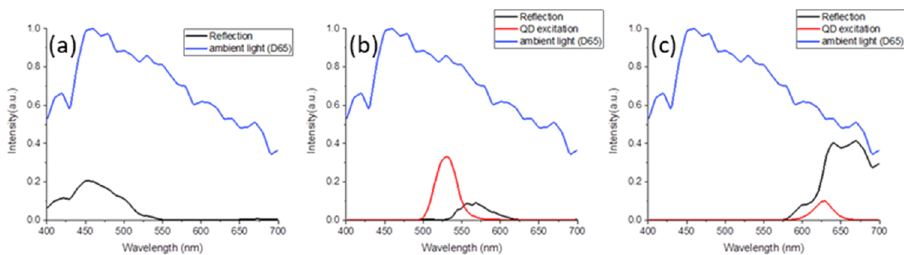
Figure 7. Calculated intensity spectrum of ambient light, reflected light for ( a ) blue, ( b ) green and ( c ) red subpixels.